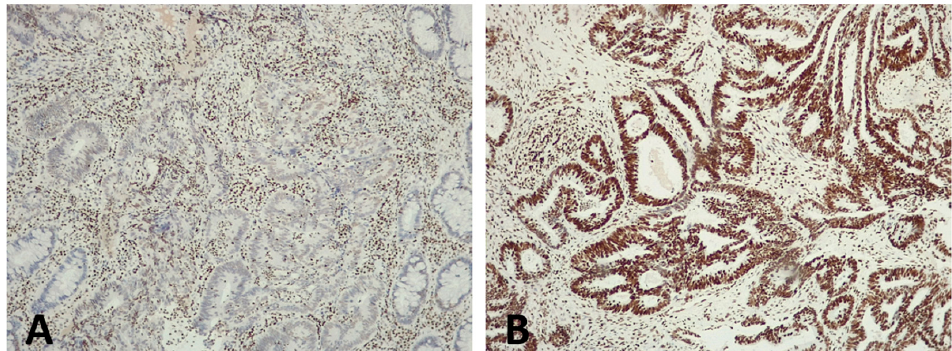
Figure 3. H3K27me3 immuno-expression in the pre-treatment biopsies of two rectal carcinomas. ( A ) Rectal carcinoma with loss of H3 K27me3 immunostaining in the neoplastic cells. Inflammatory cells, which served as internal positive control, showed nuclear immunostaining. ( B ) Rectal carcinoma with retained H3 K27me3 immunostaining.